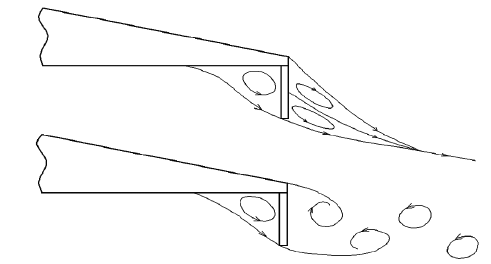
Fig. 1. Von Karman-i vortex street at the aft of the wing’s Gurnay flap (Richter 2010)